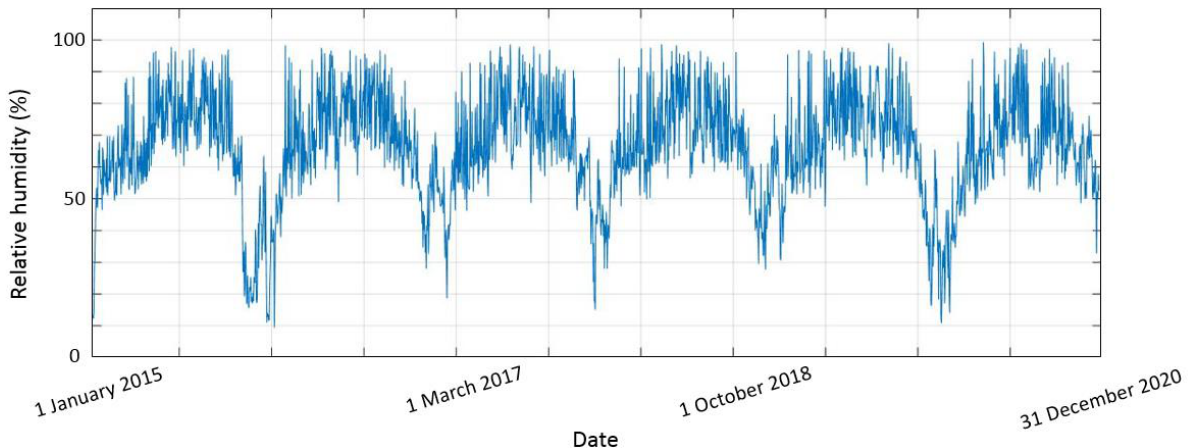
Figure 2. Relative humidity in the center of the study region.